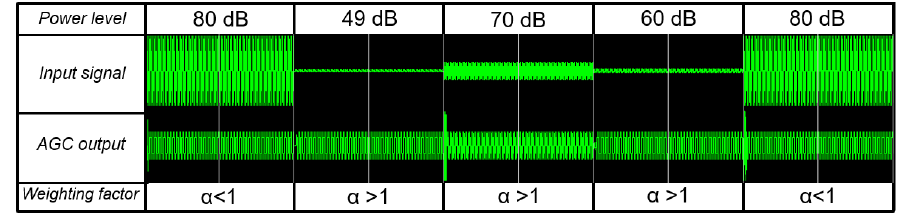
Figure 11. AGC simulation results. The power levels of AGC output were automatically maintained at around 73 dB for various input